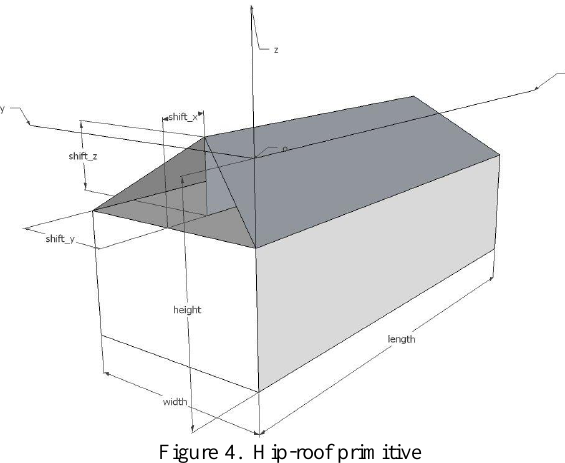
Figure 4. Hip-roof